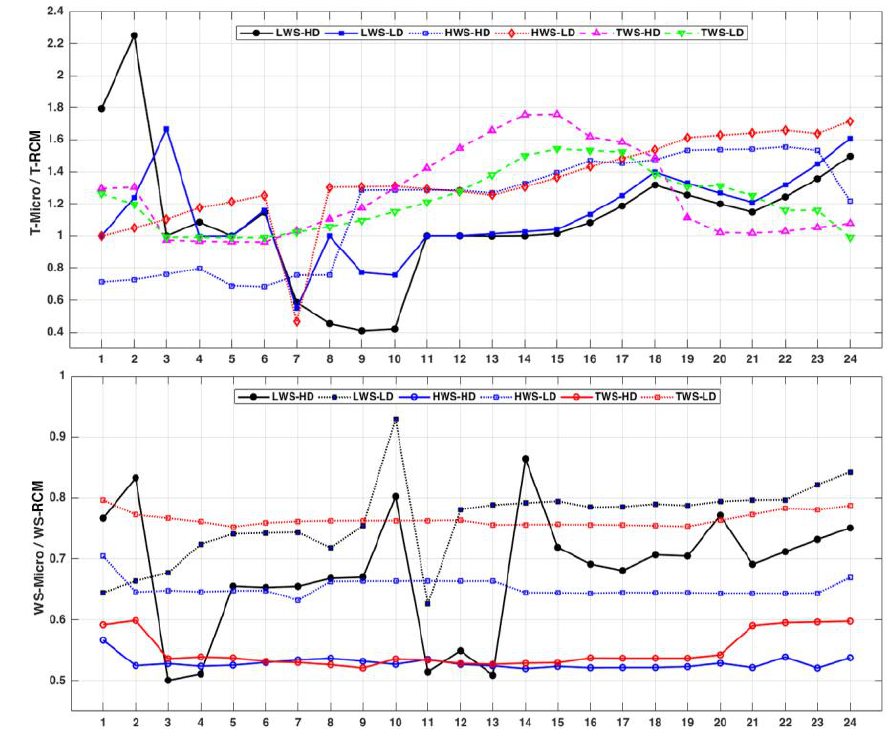
Figure 5. Normalized hourly air temperature (T) and wind speed (WS) at microscale as a function of mesoscale data (as inputs for CFD simulations). Typical wind speed (TWS): 19 February; lowest wind speed (LWS): 4 October; and highest wind speed (HWS): 15 January. HD: High density; LD: Low density.